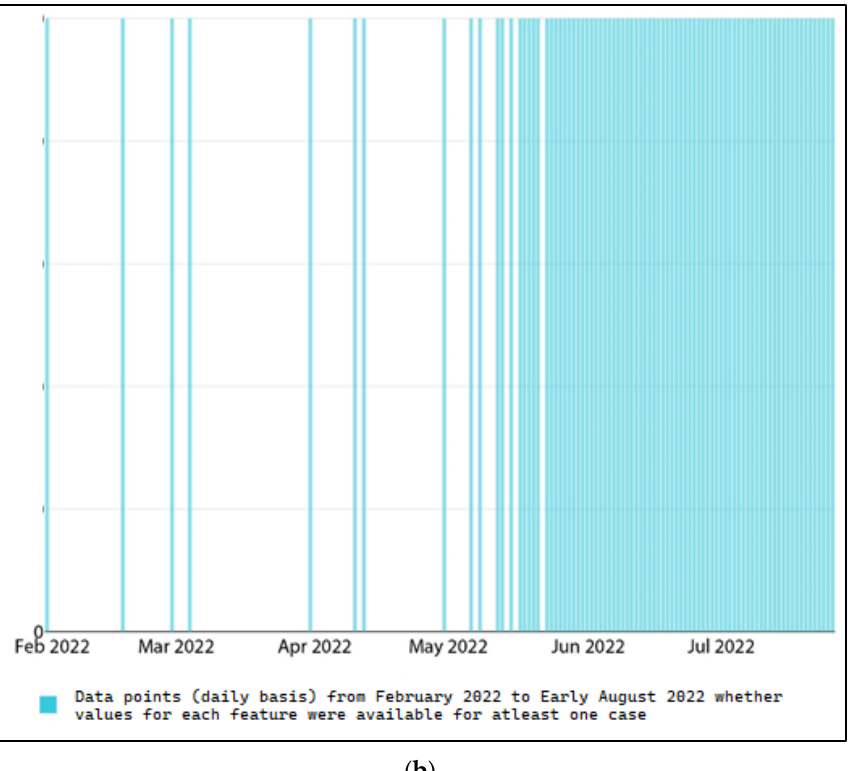
Figure 2. Few key Dataset statistics ( a ) the percentage of Null values for each of the thirteen features, ( b ) Feature completeness for cases on a daily basis from February 2022 to Early August 2022.